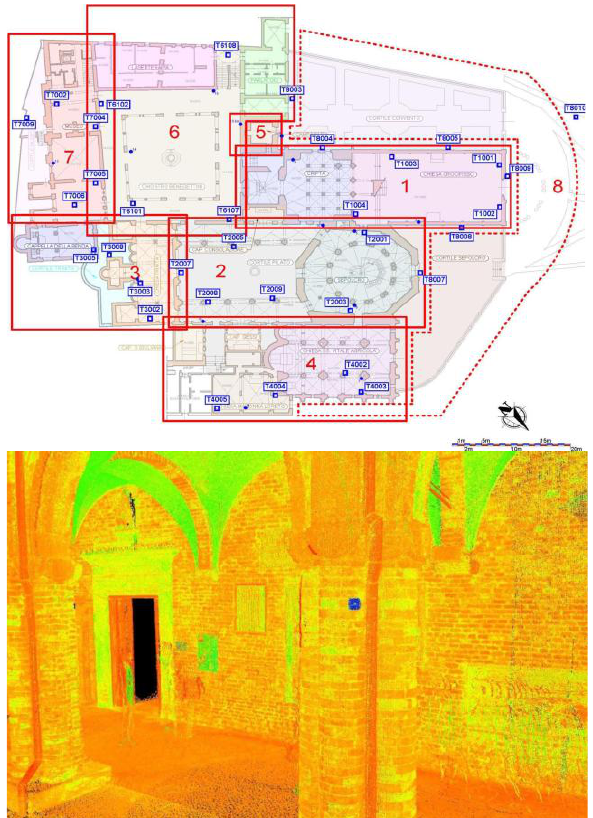
Figure 7. Validation of horizontal component: map of the selected targets that were surveyed by the total station (top); example of target as identified within the laser scanning dataset for the coordinates comparison